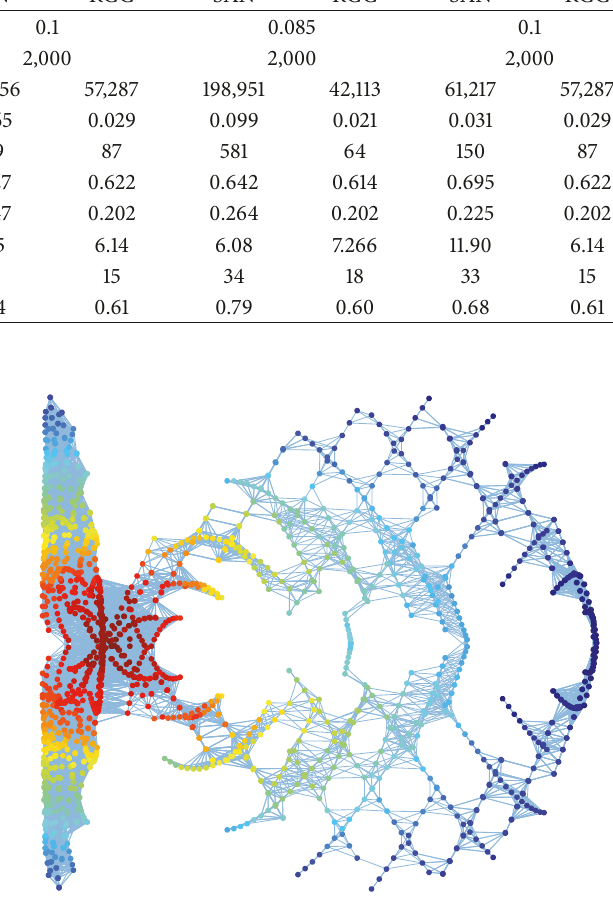
Figure 8: Spatial network constructed from the distribution of pointsinaunitsquareaccordingtothetransform 𝑇 5 usingaconnec- tion radius 𝑅 = 0.1 with 𝑛 = 2,000 points and coloring the nodes according to their closeness